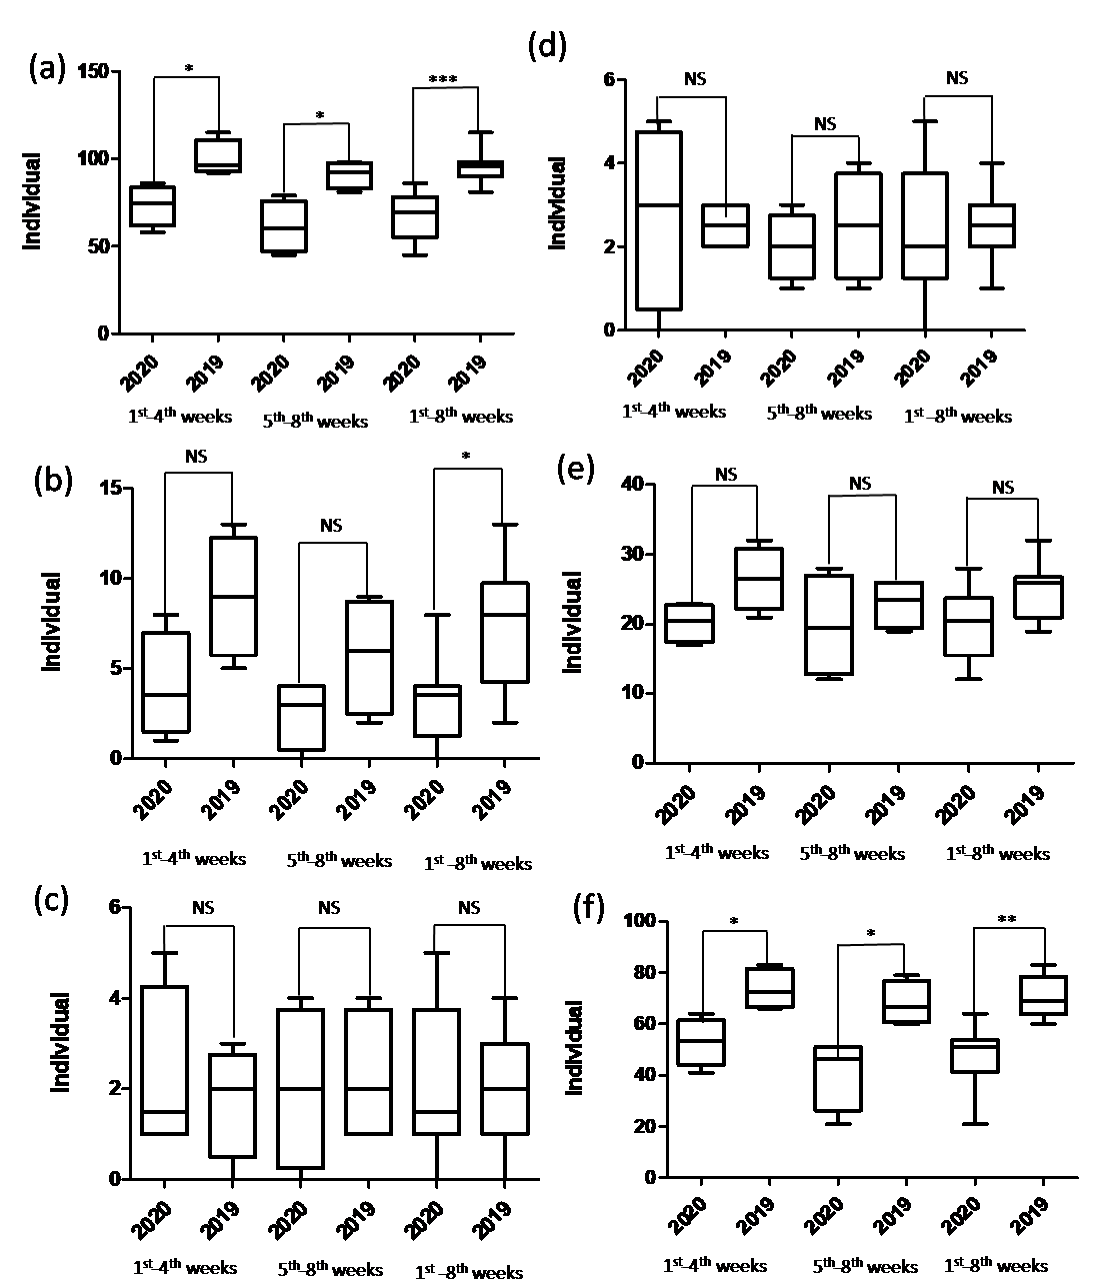
Figure 5. Box plots of the number of patients receiving ( a ) total types of surgery, ( b ) total knee arthroplasty, ( c ) total hip arthroplasty, ( d ) hemiarthroplasty, ( e ) emergency surgery, and ( f ) elective surgery at the university hospital during the study (2020) and control (2019) periods. * indicates p < 0.05. ** indicates p < 0.01. *** indicates p < 0.001. “NS” indicates insignificant.